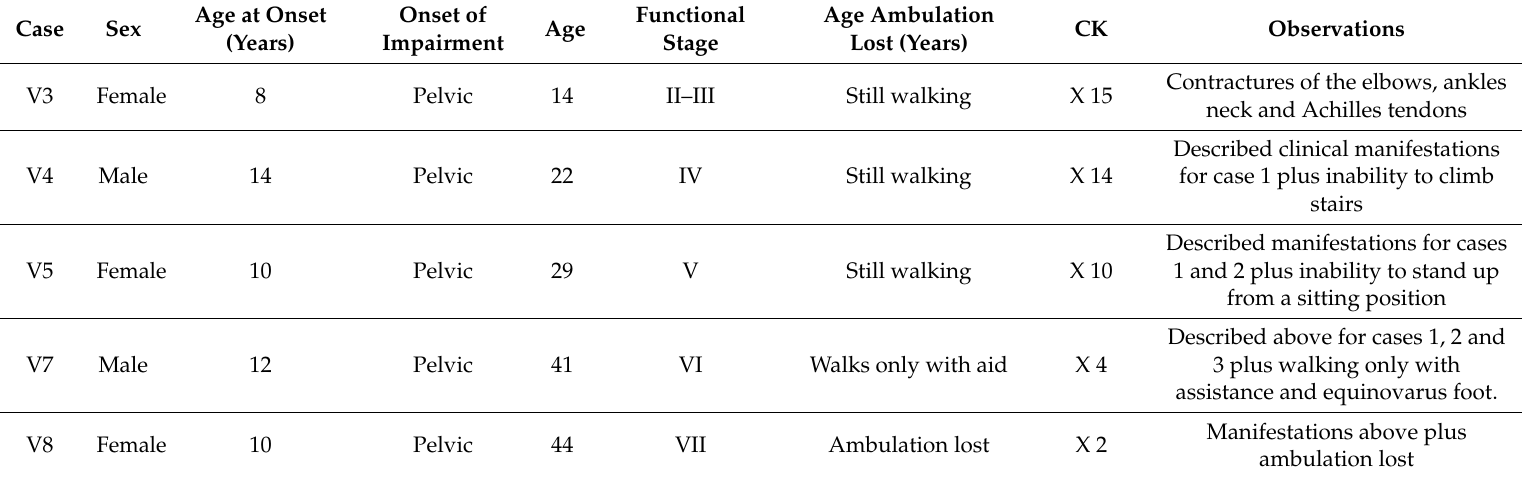
Table 1. Clinical data on Colombian calpain 3-related LGMD R1 patients. Cases are referenced as in the genealogical tree (Figure